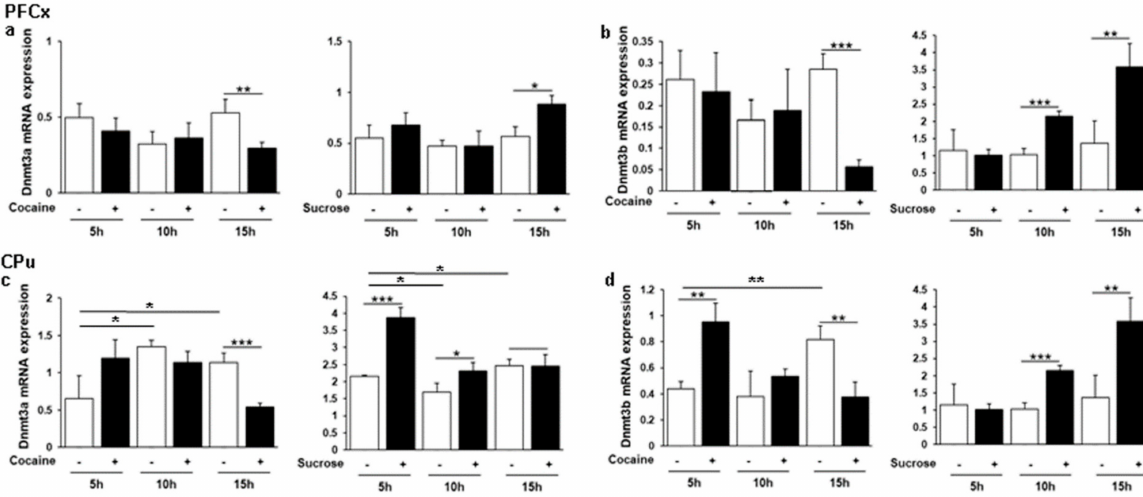
Figure 2. Relative Dnmt3a and Dnmt3b mRNA expression in the PFCx and the CPu in response to passive cocaine and sucrose intake. Cocaine and sucrose delivery was analyzed in the PFCx ( a , b ) and in the CPu ( c , d ) by quantitative RT-PCR 5 h, 10 h and 15 h after the last administration, as indicated (corresponding to ZT 6, ZT 11 and ZT 16). Dnmt3a expression in the PFCx ( a ) and in the CPu ( c ) was compared with that of Dnmt3b in the same brain structures ( b , d ), respectively. The amount of each transcript was normalized to that of 36B4. Data represent the mean ± SEM, n = 4–5 per group. Statistical analysis performed was one-way ANOVA followed by Newman-Keuls post hoc when required. Significant differences between control and treated groups and within control groups relative to ZT 6 are indicated. * p < 0.05, ** p < 0.01, *** p <